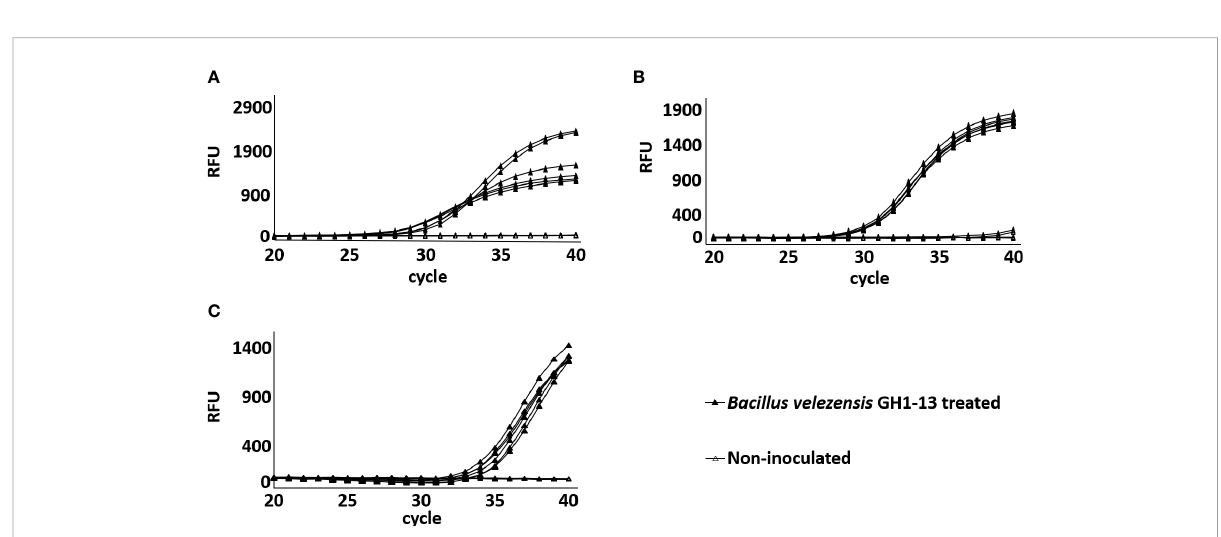
FIGURE 8 Ampli fi cation of chromosomal unique gene region of Bacillus velezensis GH1-13 by SYBR Green qPCR analysis from DNA templates of B. velezensis GH1-13 treated and non-inoculated soil samples (500 mg) collected in the fi eld after treatment for 3 h (A) , 6 months (B) and 9 months (C)